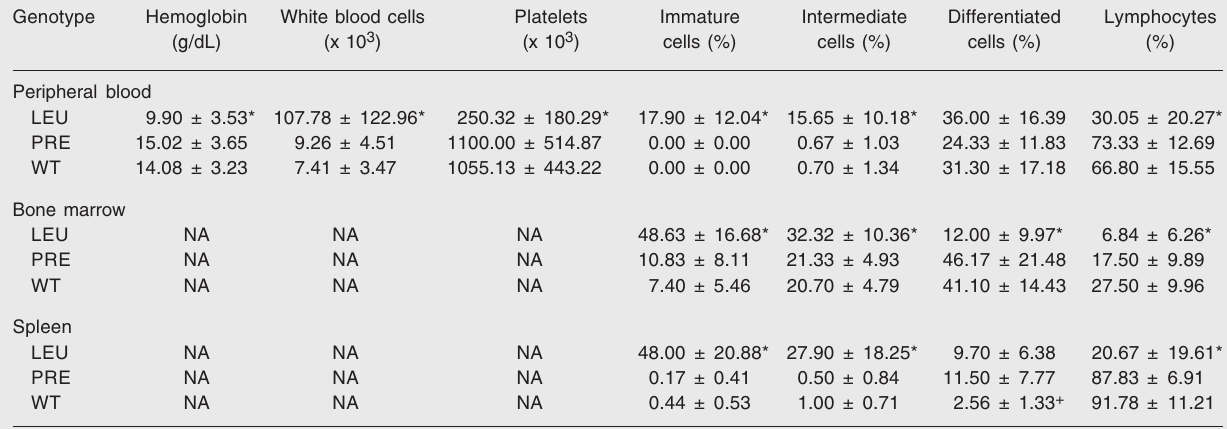
Table 1. Peripheral blood, bone marrow, and spleenic cell counts of leukemic (N = 12), pre-leukemic (N = 6), and wild-type (N = 12) mice. Genotype